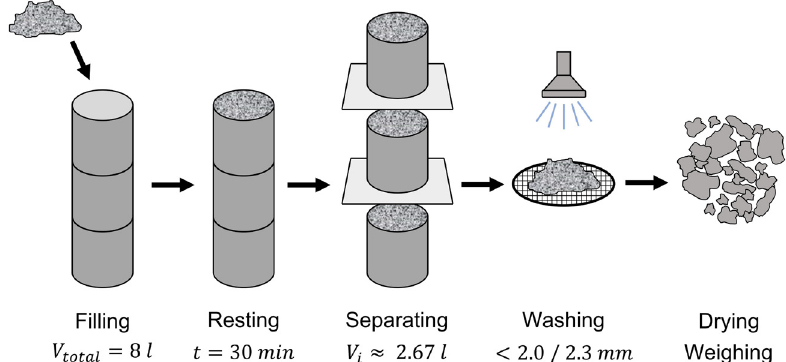
Figure 15: Schematic representation of the cylinder sedimentation test according to ref. [ 55 ]